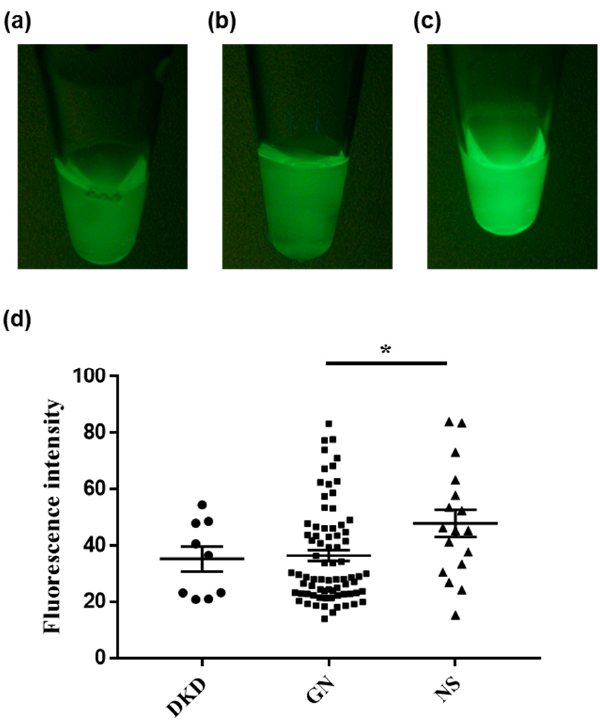
Figure 3. Fluorescence images of urine after incubation with GGT-HMRG. Representative fluores- cence images of urine obtained from patients with diabetic kidney disease ( a ), glomerulonephritis ( b ), and nephrosclerosis ( c ) after incubation with GGT-HMRG. Urine from patients with nephro- sclerosis showed a significantly high fluorescent intensity than those with glomerulonephritis. ( d ). *; p < 0.05.